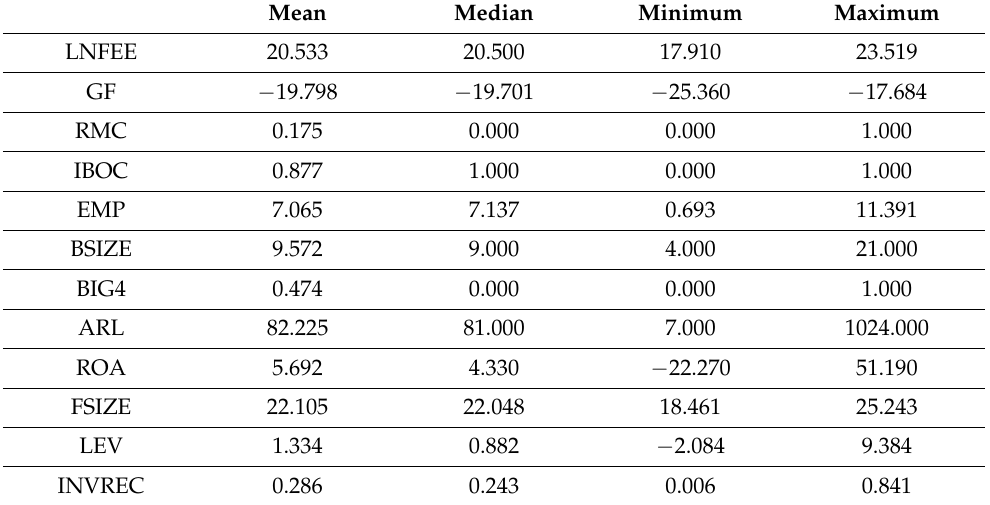
Table 5. Descriptive statistics.